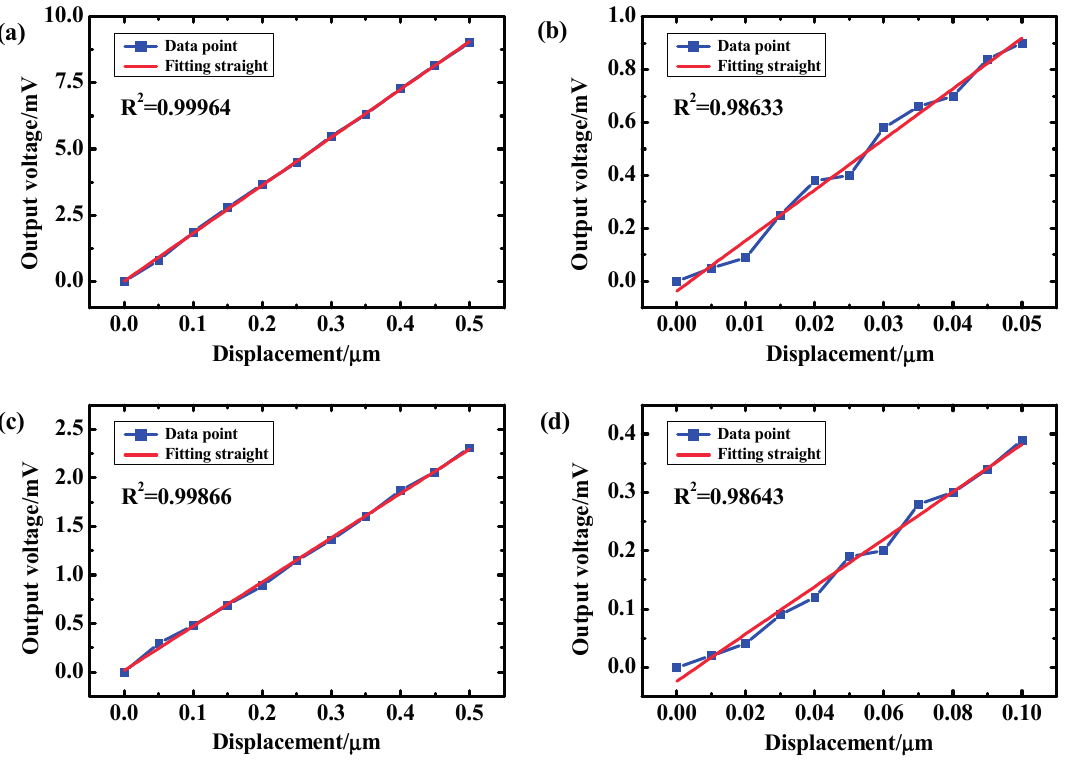
Figure 10. Resolution test. ( a ) Vertical 50 nm step; ( b ) Vertical 5 nm step; ( c ) Lateral 50 nm step; ( d ) Lateral 10 nm